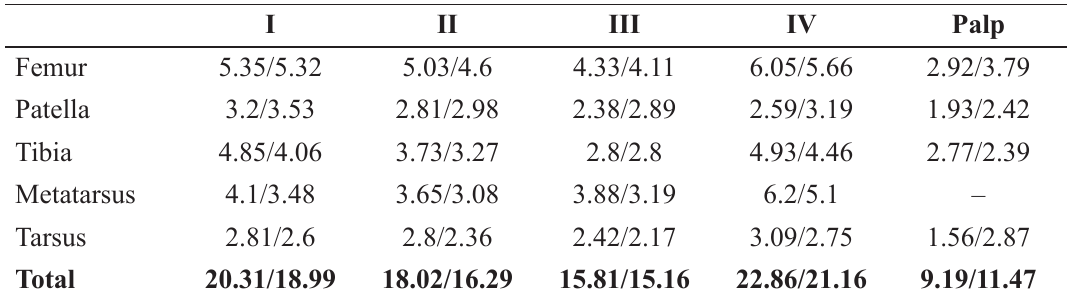
Table 2. Length of legs and palpal segments of holotype, ♂ (MZSP 28423) / paratype, ♀ (MZSP 28424) of Schismatothele caiquetia sp.